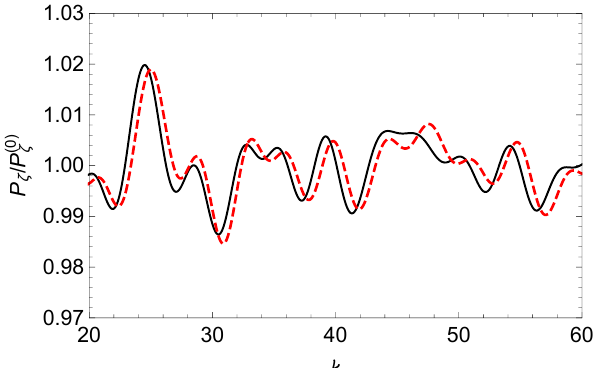
Figure 2 . Correction to the primordial spectrum in the low k range. k is in unit of H . We (cid:12)x (cid:3) = 6000 H; M = 1020 H; m (cid:31) = 10 H; m h = 2 H; (cid:21) = 1. Black: full numerical result; red